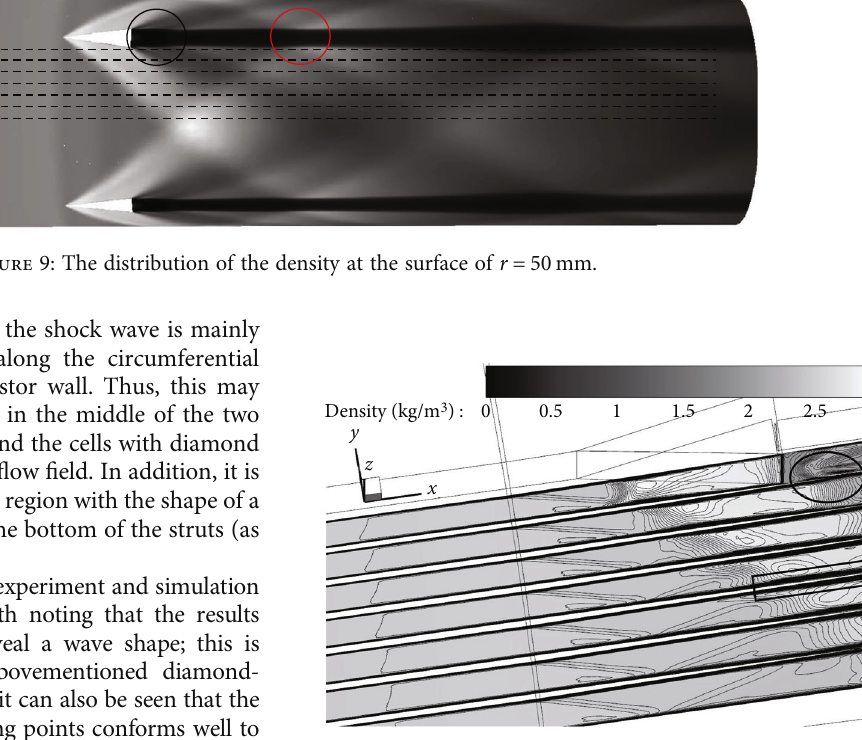
Figure 10: The density distribution of di ff erent surface parallel to the XZ